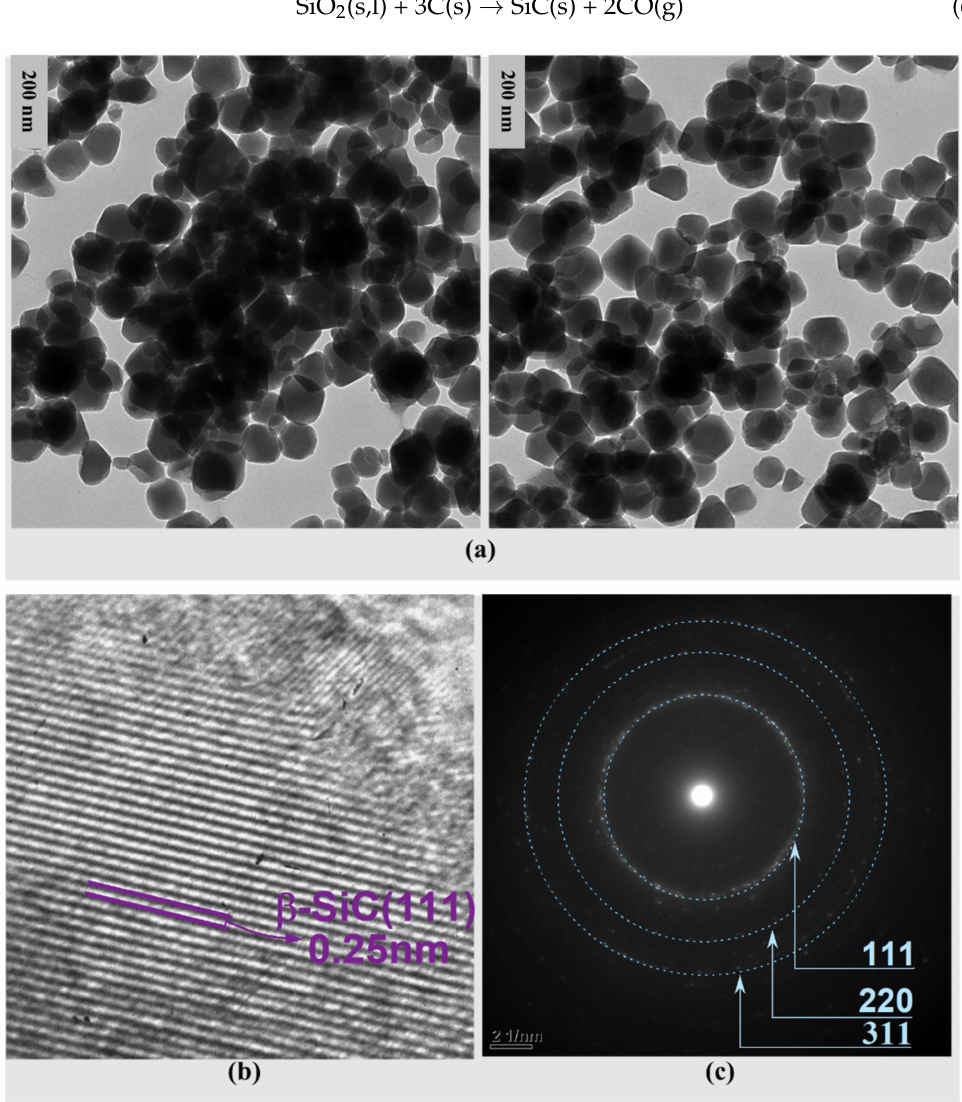
Figure 6. ( a ) A general low-resolution TEM image, ( b ) a representative high-resolution, ( c ) a corre- sponding selected area electron diffraction pattern of SiC nanoparticles obtained at 1400 ◦ C for 1 h (Adapted from Hemati, et al.